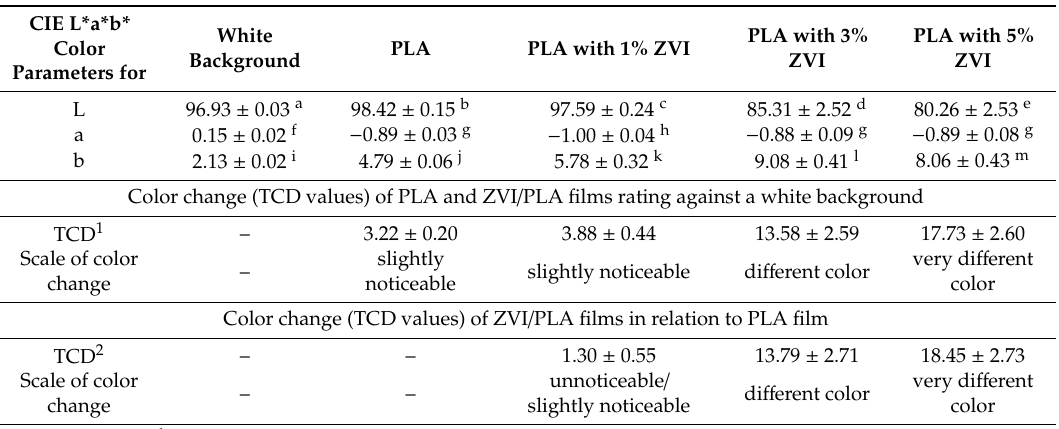
Table 2. Color parameters (in CIE L*a*b* system) obtained for white background, pure PLA films and PLA with the di ff erent addition of ZVI, followed by total color di ff erence index values calculated for the color comparison of PLA and ZVI / PLA films with the color of white background (TCD 1 ) and for the comparison of ZVI / PLA with pure PLA films (TCD 2 ).